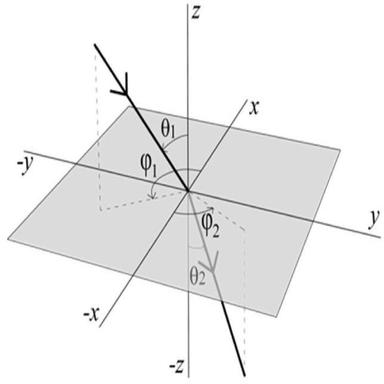
Incoming and outgoing angles of transmission relative to the sample fenestration material.